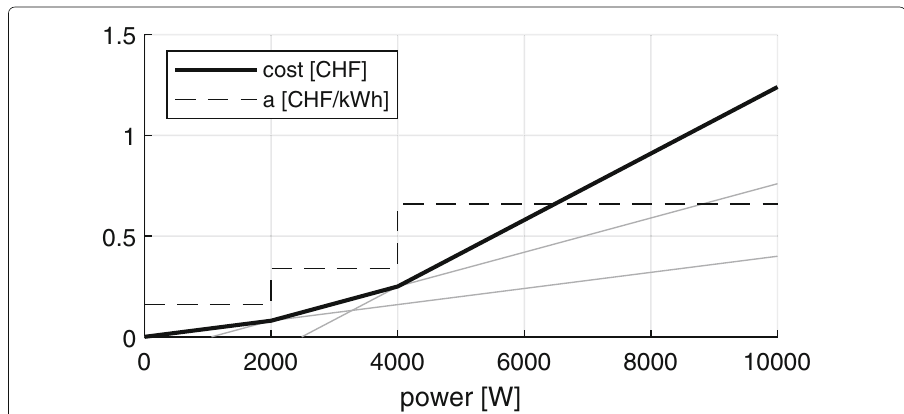
Fig. 3 Block rate tariff obtained by fixing the following tariff : a = (0.16,0.34,0.66) CHF/kWh for the power ranges ([0-2],[2-4],[4- ∞ ])kW with a time step of 15 min